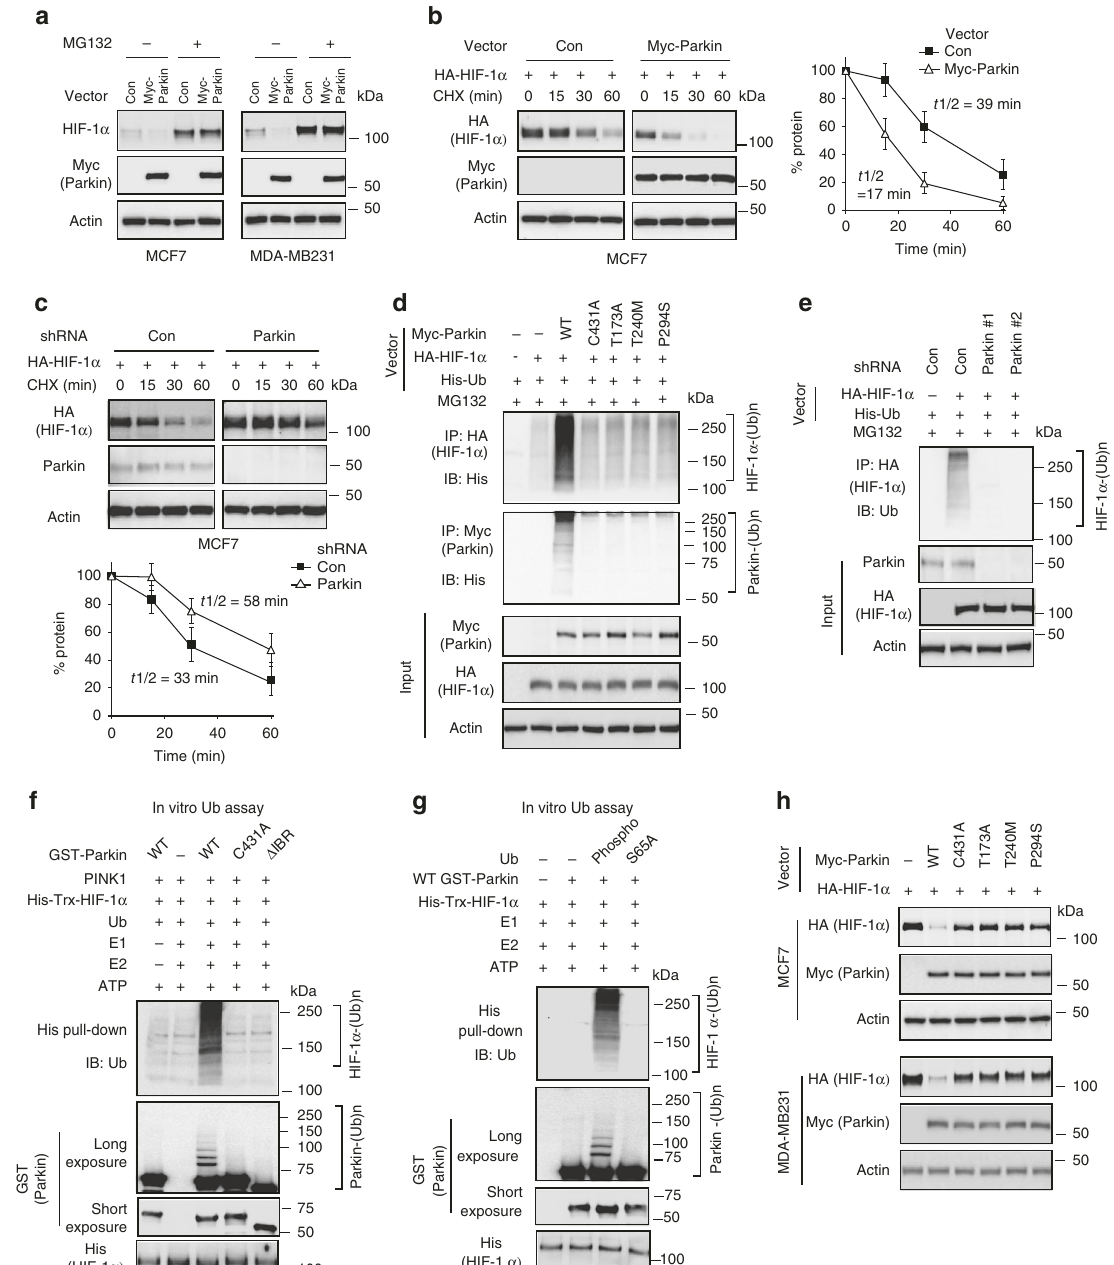
Fig. 4 Parkin promotes HIF-1 α protein degradation through ubiquitination. a Proteasome inhibitor MG132 inhibited the downregulation of HIF-1 α protein levels induced by Myc-Parkin expression in MCF7 and MDA-MB231 cells. b Myc-Parkin expression decreased HIF-1 α protein half-life in cells. MCF7 cells with ectopic Myc-Parkin expression and control cells were transfected with the HA-HIF-1 α vector. The cells were treated with 50 µ g ml − 1 CHX for indicated time periods before being collected for western-blot assays. c Knockdown of endogenous Parkin increased HIF-1 α protein half-life in MCF7 cells. In b , c , the data present mean ± S.D. ( n = 3). d The effects of expression of Myc-Parkin and its mutants on ubiquitination of HA-HIF-1 α and autoubiquitination of Parkin in MCF7 cells analyzed by in vivo ubiquitination assays. e Knockdown of endogenous Parkin decreased the ubiquitination of HA-HIF-1 α in MCF7 cells analyzed by in vivo ubiquitination assays. f Parkin promoted HIF-1 α ubiquitination as detected by in vitro ubiquitination assays performed by incubating puri fi ed GST-Parkin and His-Trx-HIF-1 α proteins in the presence of recombinant E1, E2, ubiquitin (Ub) and PINK1 proteins in vitro. g S65A Ub largely abolished ubiquitination of HIF-1 α by Parkin in vitro. In vitro ubiquitination assays performed by incubating puri fi ed GST-Parkin and His-Trx-HIF-1 α proteins in the presence of phosphorylated (Phospho) Ub or S65A Ub. h Mutations of Parkin that impaired Parkin ’ s ubiquitination activity impaired the ability of Myc-Parkin to degrade HA-HIF-1 α protein in MCF7 and MDA-MB231